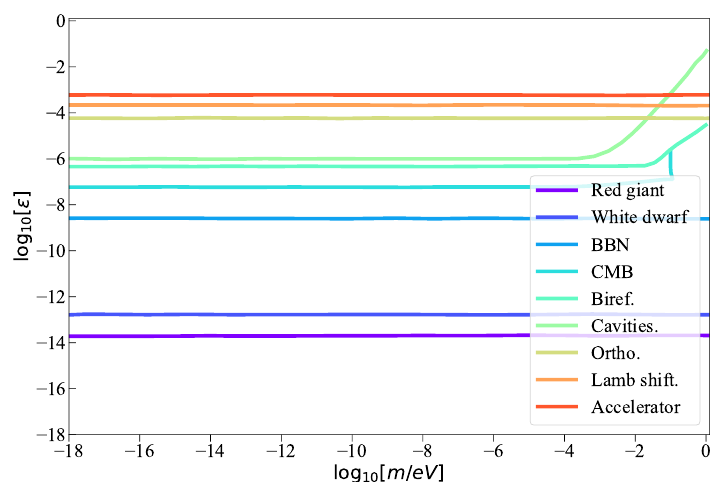
Figure 1 . Constraints on light mCPs from various terrestrial, astrophysical and cosmological considerations [15, 16, 20{23]. The most stringent limits are from Red giant and White dwarf stellar cooling constraints, and seemingly restrict the viable mCP charge to (cid:15) . 10 (cid:0) 14